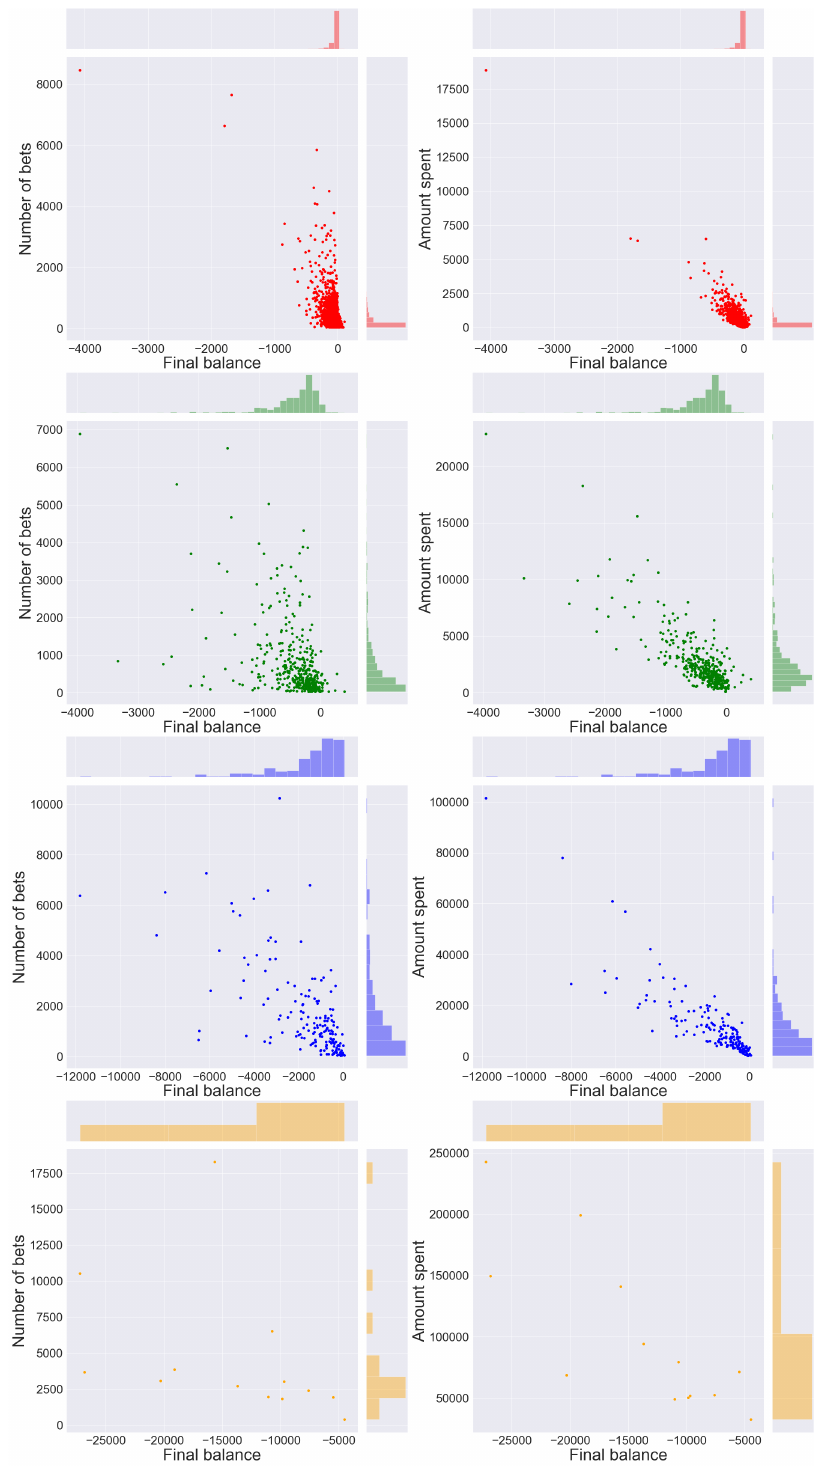
Figure 18. Bivariate scatter plots obtained using the time series k -means algorithm. Each row of this figure highlight for a single cluster the relationships between the final balance-number of bets and the final balance-amount